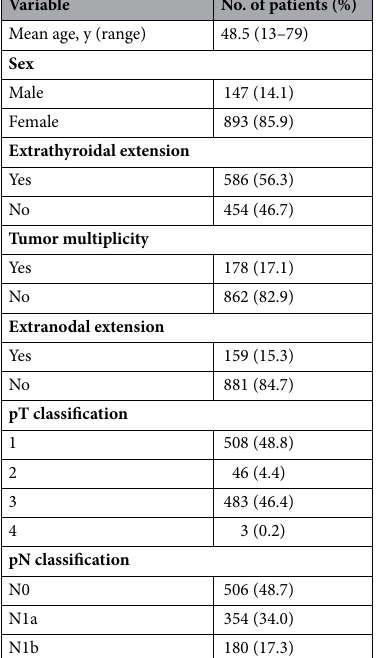
Table 1. Clinical information for all patients (n = 1040) enrolled in the